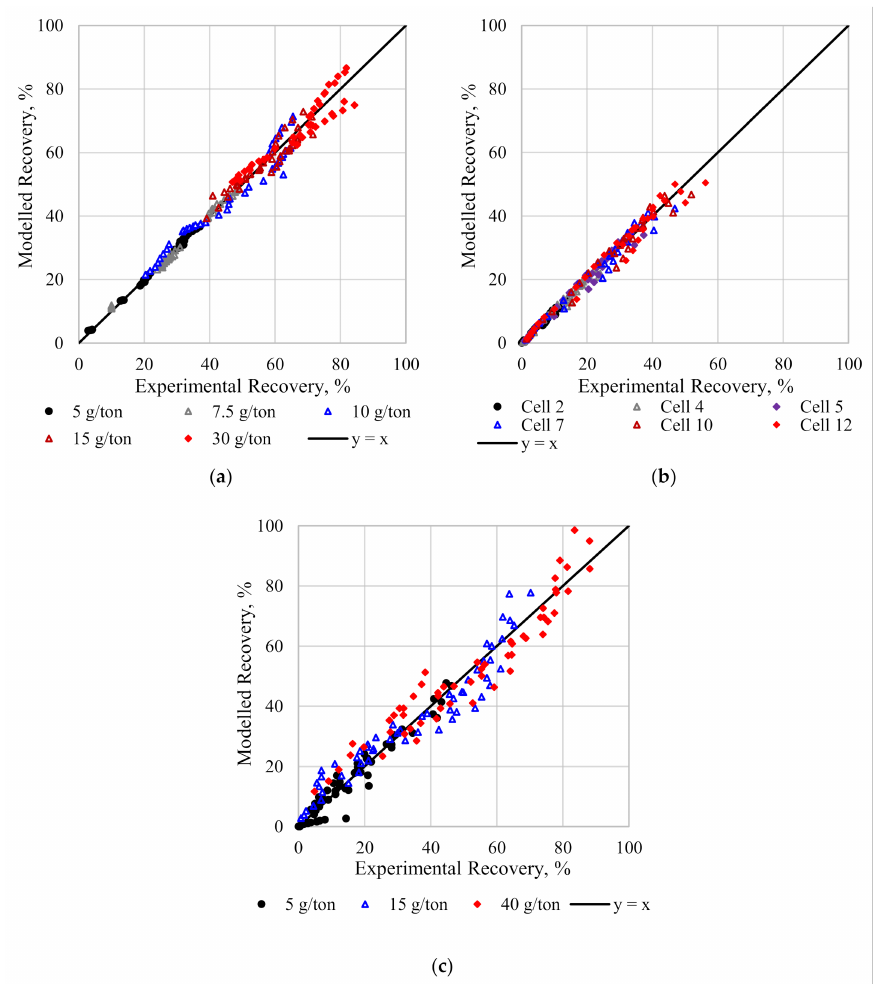
Figure 4. Comparison between measured and modelled size-by-liberation galena recoveries: ( a ) Vianna [8], ( b ) Savassi [13], ( c ) Welsby [9]. Middling particles (10–90%